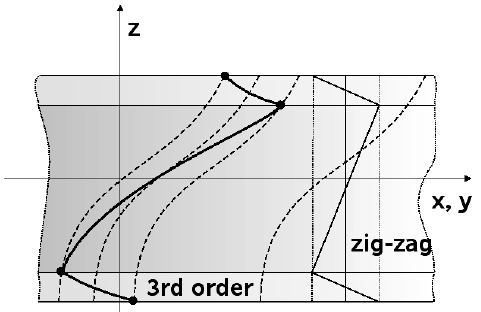
Fig. 4. Third-order polynomial approximation with Murakami’s zig-zag function for the Equivalent Single Layer approach.